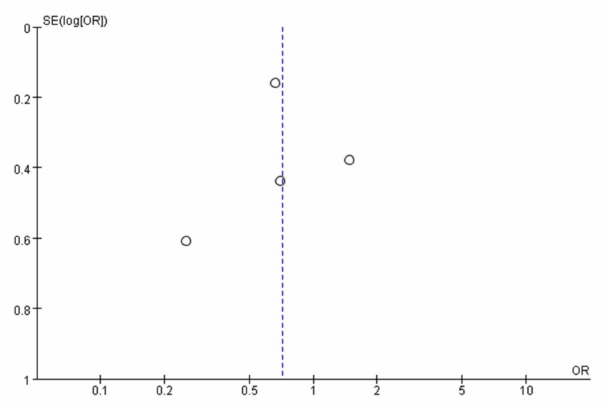
Figure 4. Funnel plot demonstrating the absence of publication bias in the response rate